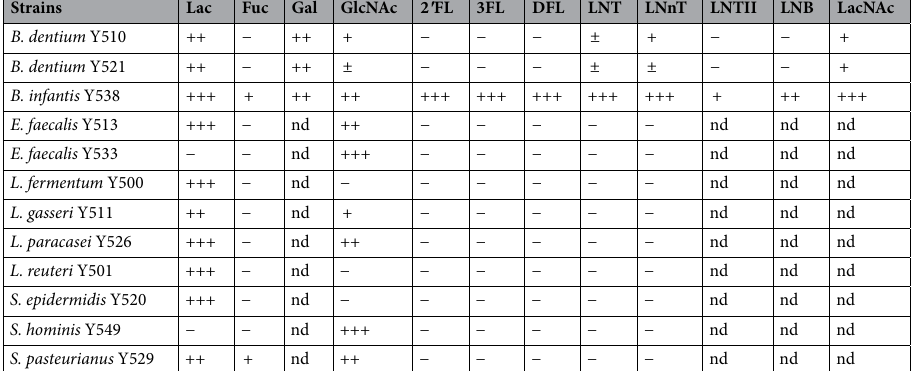
Table 1. Utilization of monosaccharides and human milk oligosaccharides by infant-gut associated bacterial strains a . a Level of bacterial growth was classified as follows: Bifidobacterium strains, OD 595 < 0.12 (−), OD 595 0.12–0.2 (±), OD 595 0.2–0.3 (+), OD 595 0.3–0.5 (++) and OD 595 > 0.5 (+++); E. faecalis Y513, OD 595 < 1.0 (−), OD 595 1.0–1.2 (++) and OD 595 > 1.2 (+++); E. faecalis Y533, OD 595 < 0.5 (−) and OD 595 > 0.5 (+++); L. fermentum ,